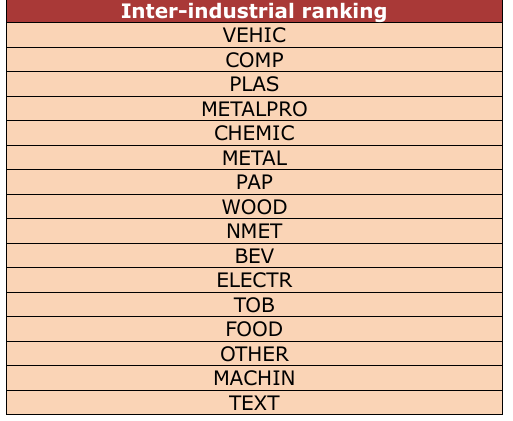
Table 4. Ranking according to the multi-criteria model